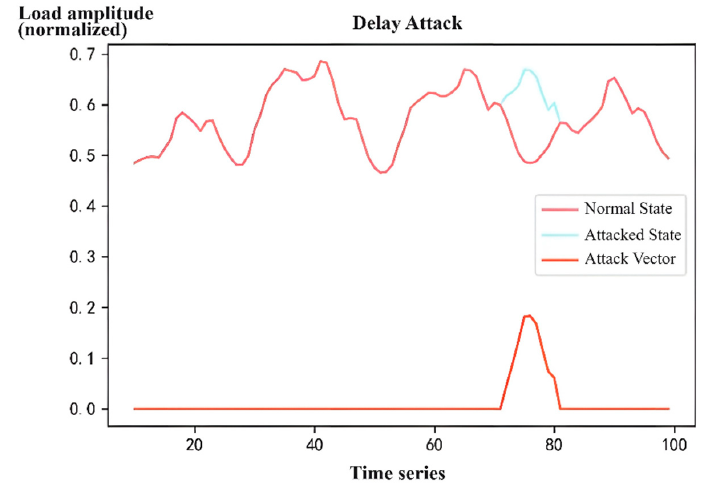
Figure 4. Delay attack.